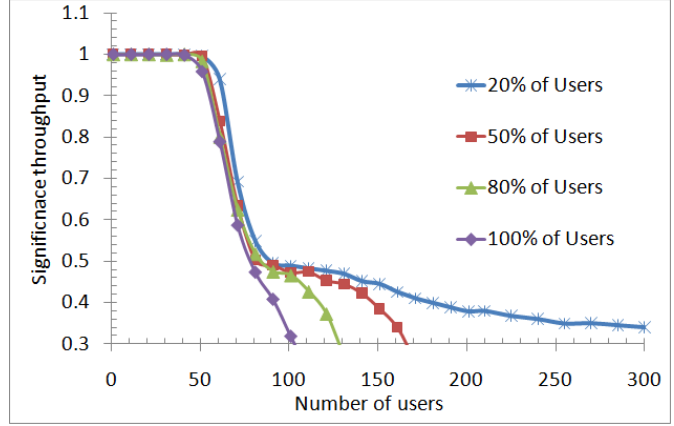
Figure 6. Significance throughput versus number of users for different classes of users and α = 0.25.